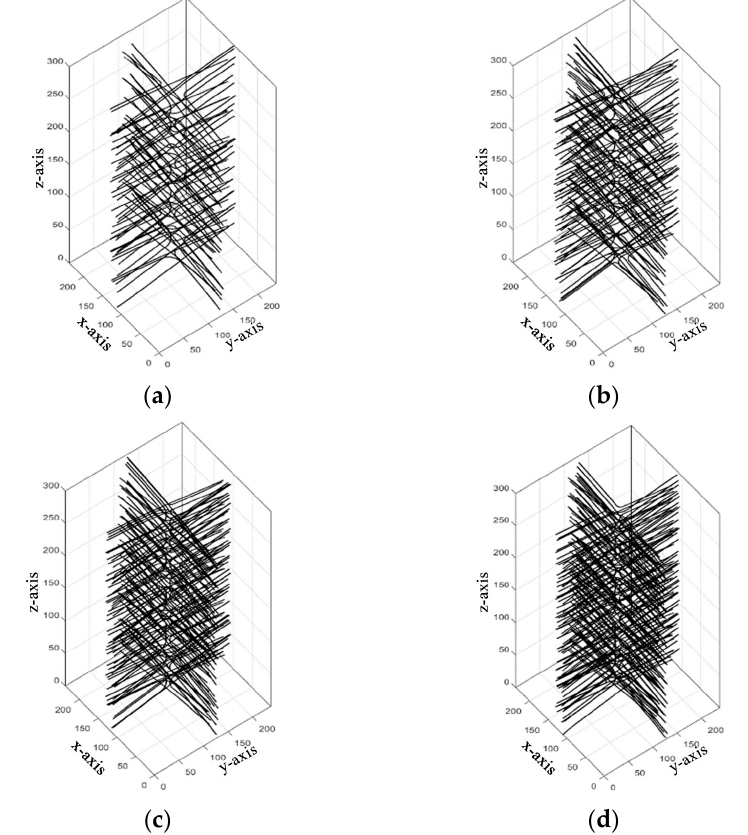
Figure 14. Optimal spatio-temporal trajectories for vehicles in different test scenarios. ( a ) 90A; ( b ) 120A; ( c ) 150A; ( d ) 180A.